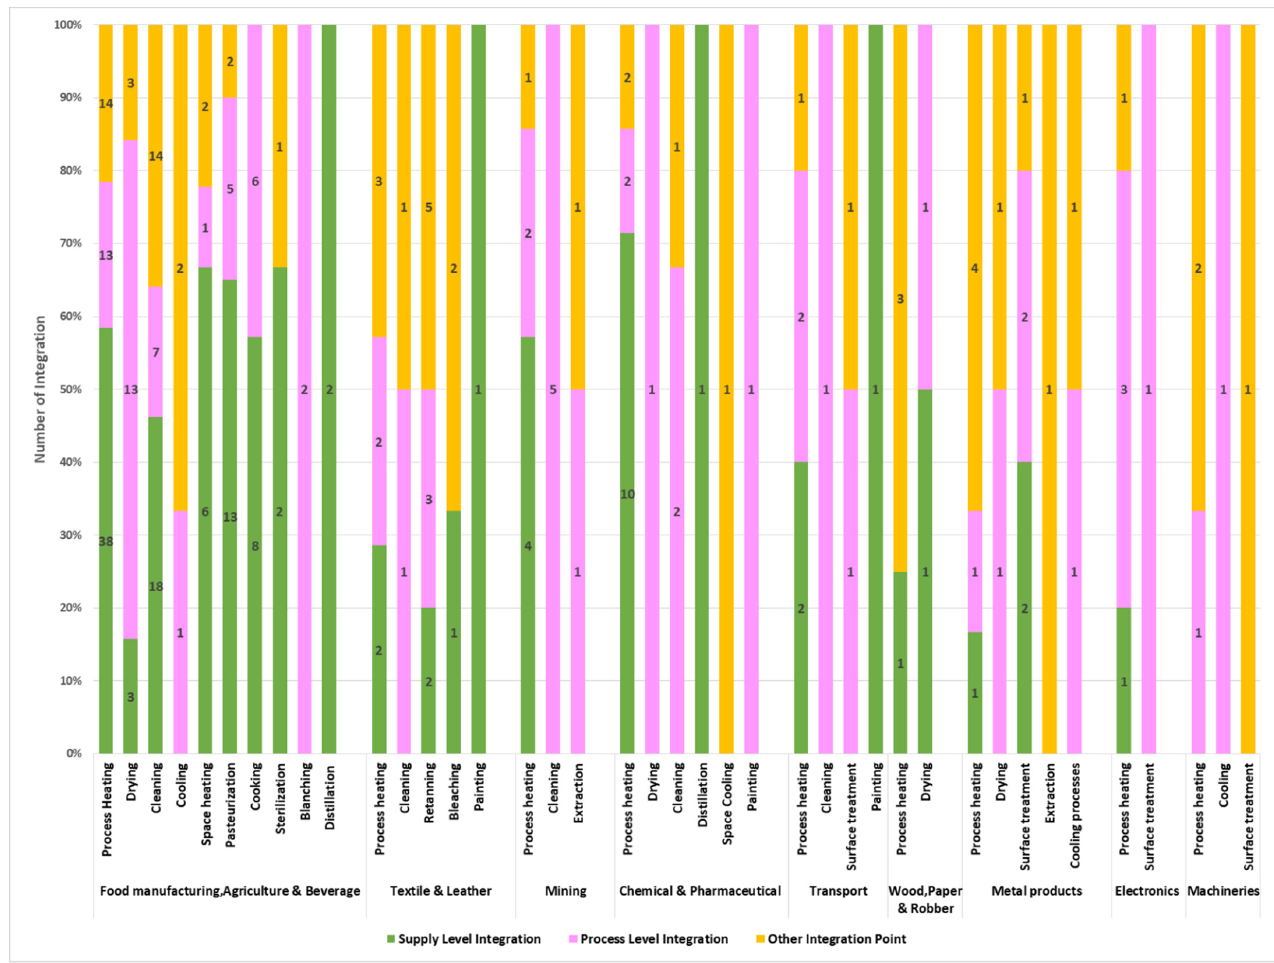
Figure 15. Percentage comparison of integration points for Solar Process Heat in industries [71].